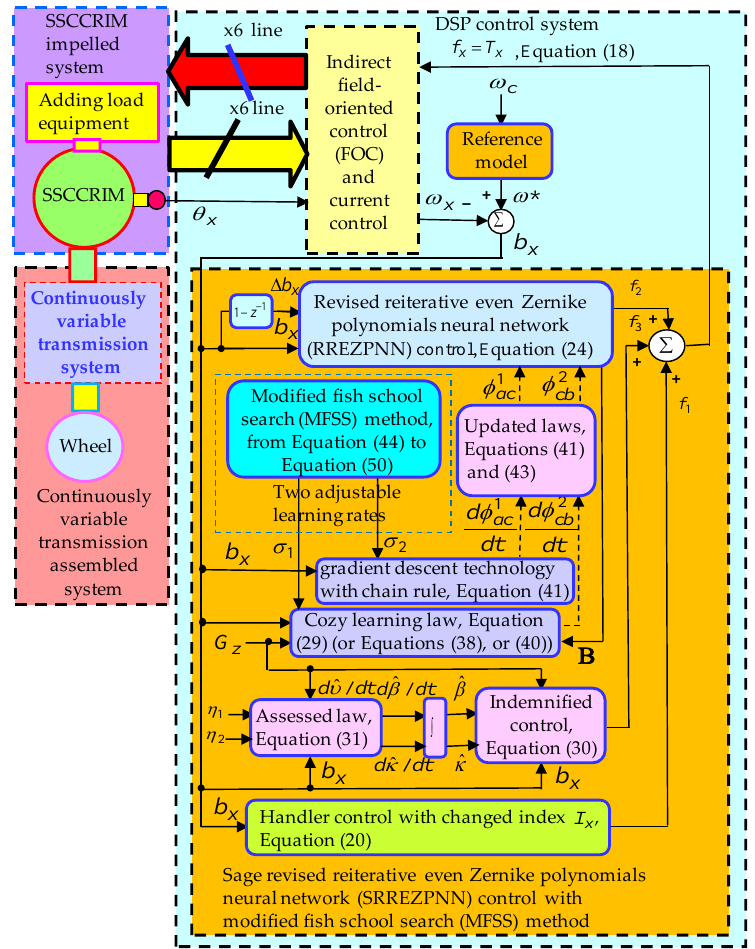
Figure 3. Block diagram of the SRREZPNN control with MFSS method.